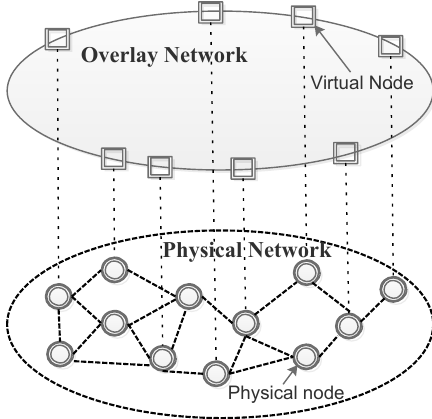
Figure 3. Topology based on virtual overlay [87] (Republished with permission of IEEE, from SDN-Based Application Framework for Wireless Sensor and Actor Networks, Zhou, J.; Jiang, H.; Wu, J.; Wu, L.; Zhu, C.; Li, W., 4, 1583–1594, 2017